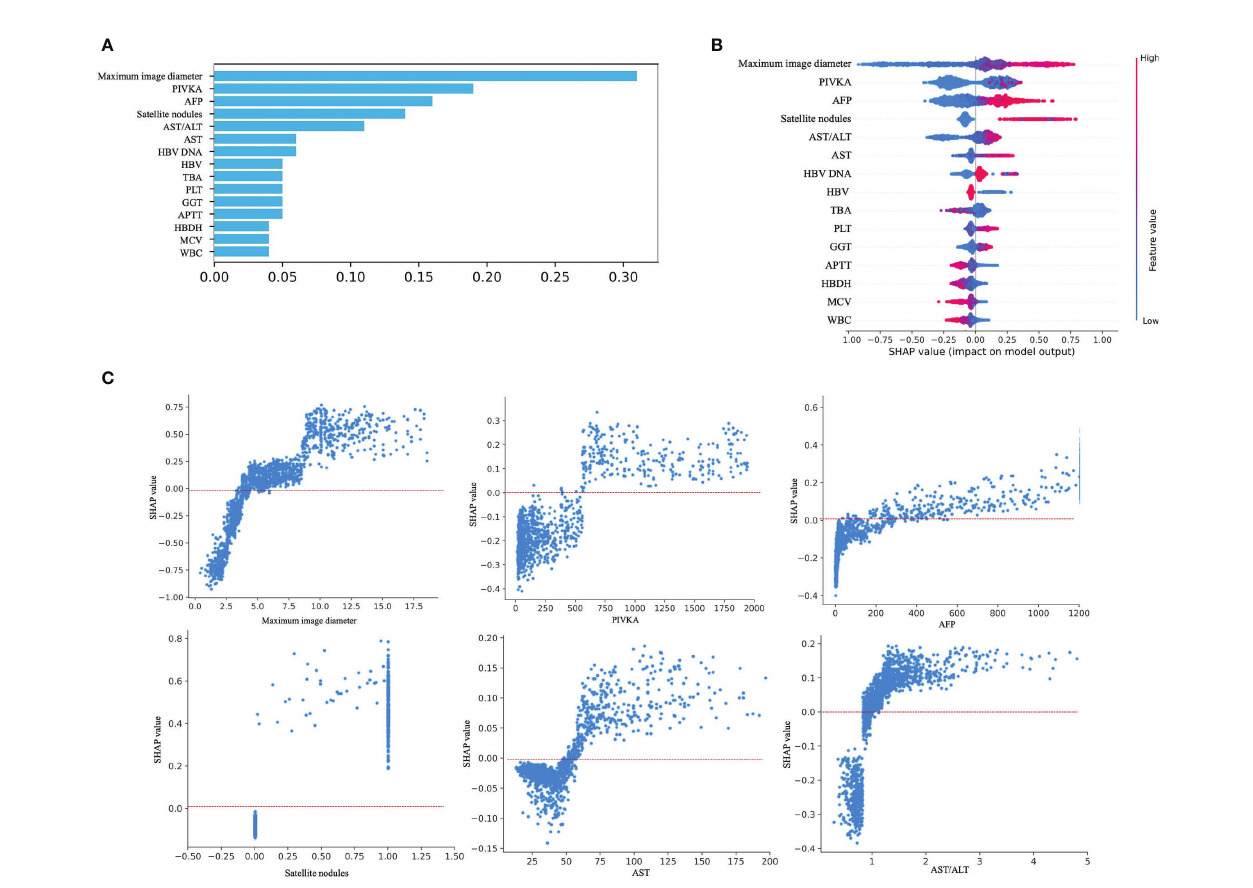
FIGURE 4 | Model interpretation. (A) Feature importance matrix plot derived from XGBoost model. (B) SHAP summary plot of the XGBoost model. The higher the SHAP value for each feature, the higher risk of MVI development. A dot represents each feature contribution for each patient in the model. Red indicates a high SHAP value, blue indicates a low SHAP value. (C) SHAP dependance plot of XGBoost model. The SHAP dependance plot represents the contribution of each feature that we care about to the output of the XGBoost model. If the SHAP value of the feature we care about is exceeds zero, the higher the risk of MVI will